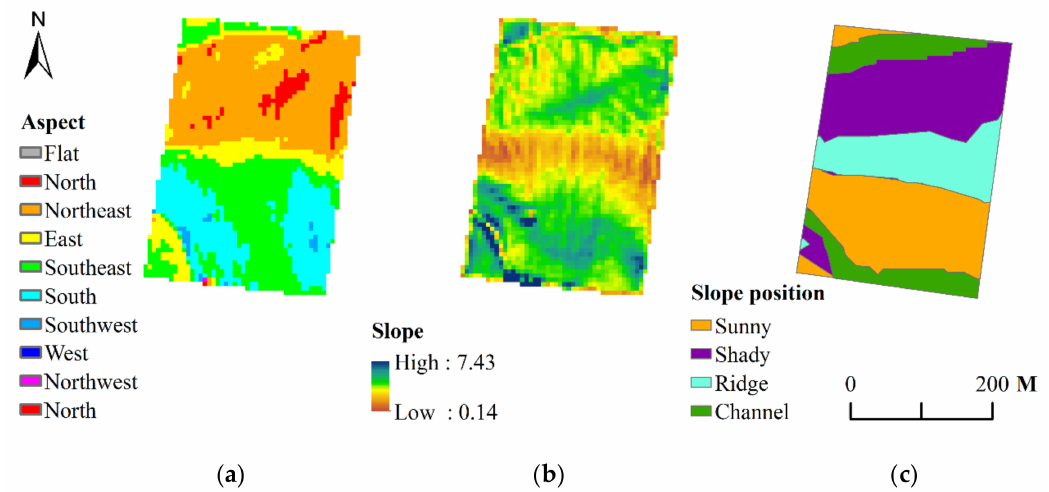
Figure 2. The slope, aspect and position maps of the training area a (( a ): aspect, ( b ): slope, and ( c ): slope